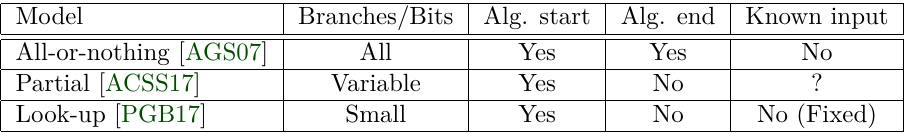
Table 1: Binary GCD side-channel models